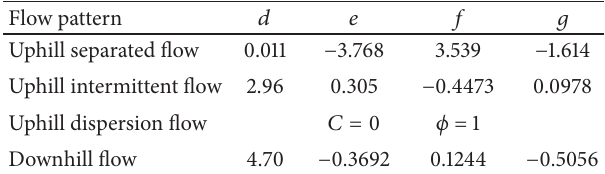
Table 7: Coefficient